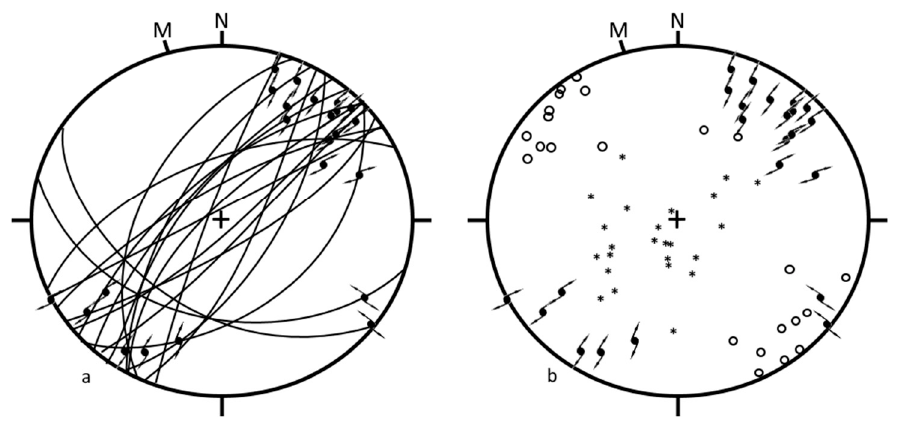
Figure 6. Regime 5. Lower Hemisphere Equal Area projection of ( a ) great circles of fault planes and ( b ) of poles to fault planes (open circles) and of calculated trend and plunge (*) of σ 2. Symbols are as in Figure 3.